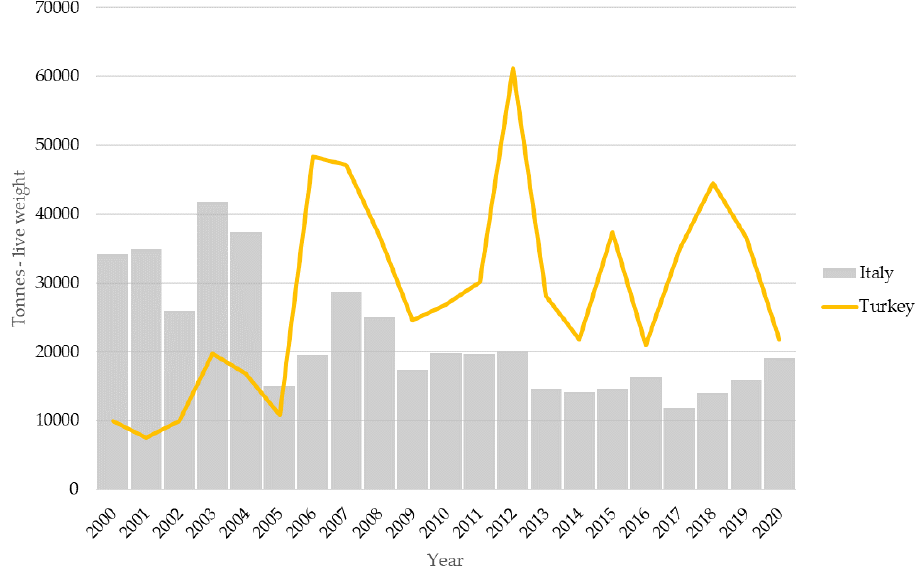
Figure 2. Comparison between Italian (grey) and Turkish (yellow) production of striped venus ( Chamelea gallina ) from 2000 to 2020 ([4,5]; Bivalve Molluscs Activities of official control 2018 (FishStatJ v. 4.02.06)).